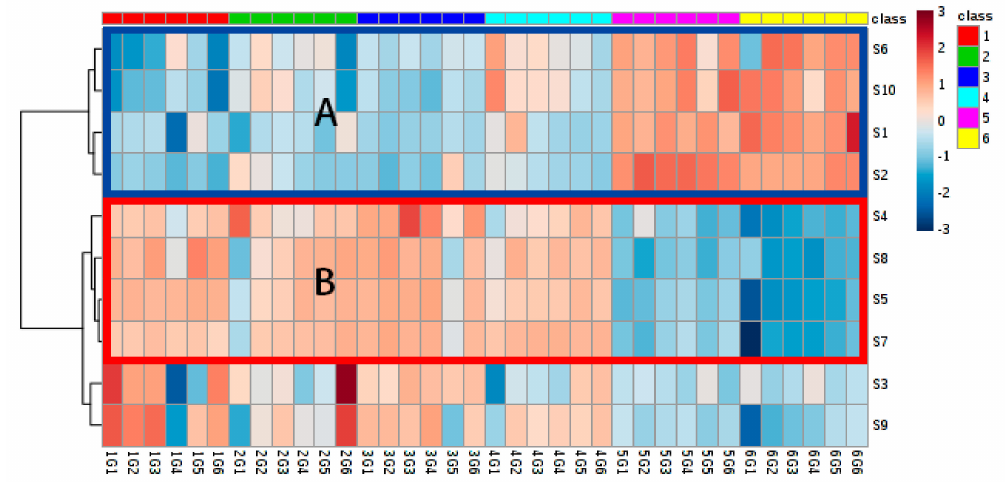
Figure 4. Heatmap of stable signals of E-nose sensors for six grades of jasmine tea (*Note: S1–S10 represent the ten sensors of the E-nose; 1G1, 1G2, 1G3, 1G4, 1G5, and 1G6 represent the six repeats of grade 1 jasmine tea, as do the following grade samples; The blue frame ( A ) indicates sensors with a negative correlation to the grade; The red frame ( B ) indicates sensors with a positive correlation to the grade).